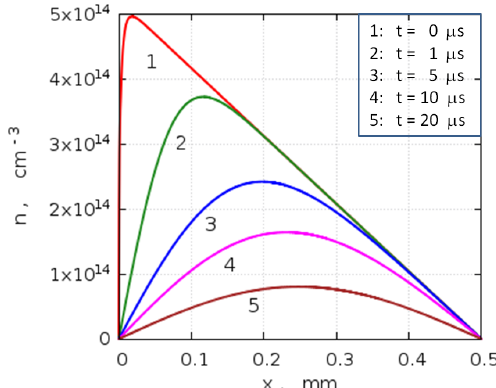
Figure 9: Decay of the photo-electron distribution in a Si wafer s 1 after the turning off the blue light with power flux P L = 10 W/cm 2 at the moment t = 0 (curves 1 to 5 show simulation results at the time t = 0, 1, 5, 10, and 20 µ s, respectively, when τ R = 6000 µ s and τ S = 0